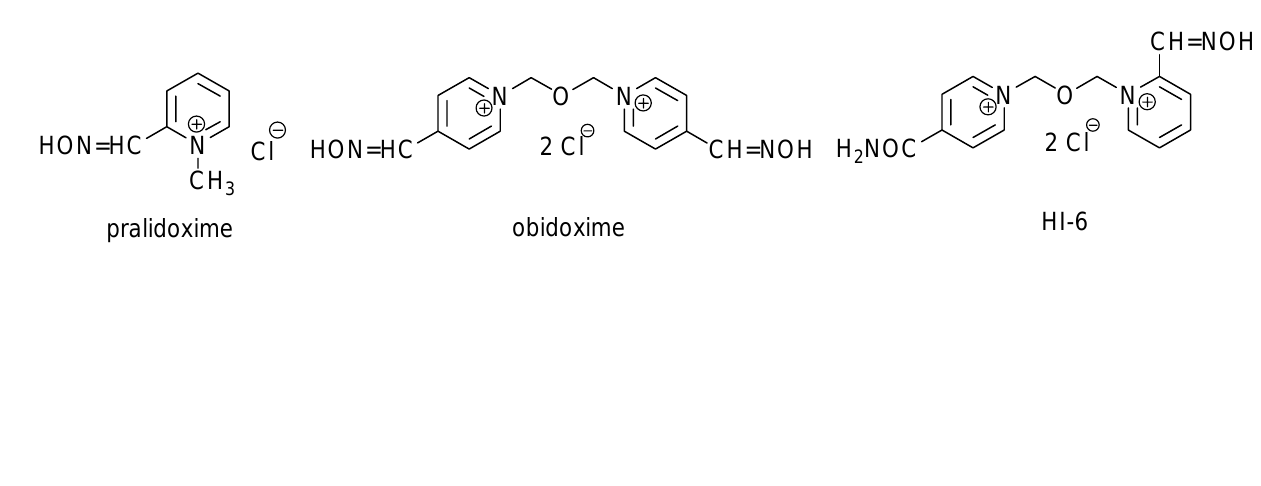
Figure 1. Chemical structures of clinically used acetylcholinesterase